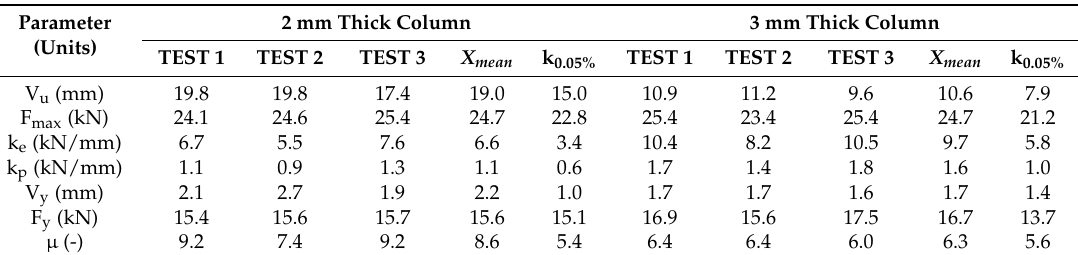
Figure 4. Type of failure evidenced during tests: ( a ) Specimens with 2 mm thick steel column; ( b ) specimens with 3 mm thick steel column. Table 1. Main mechanical parameters of the tested specimens according to EN 12512 method b [17]; characteristic values according to EN1990 [24].